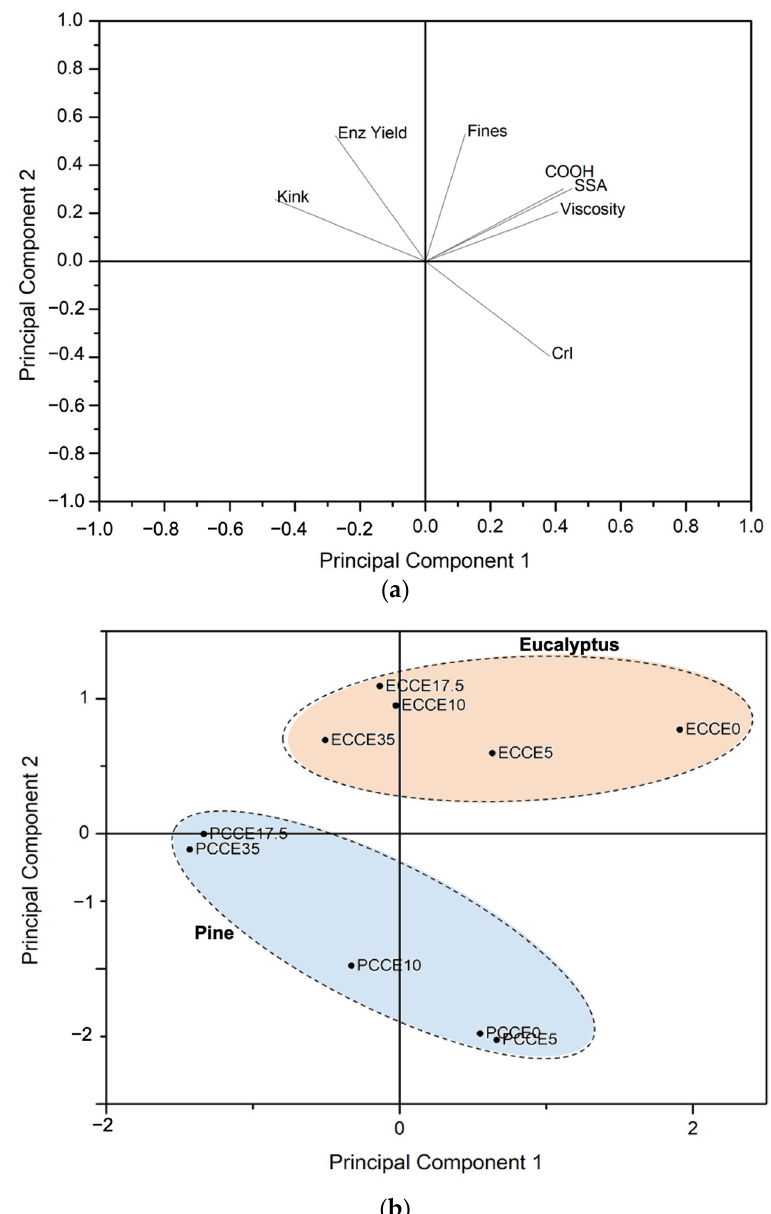
Figure 9. Principal component analysis. ( a ) Loading graph showing the contribution of variables to the PC1 and PC2. ( b ) Score graph showing the observations on the coordinates of the PC1 and PC2.